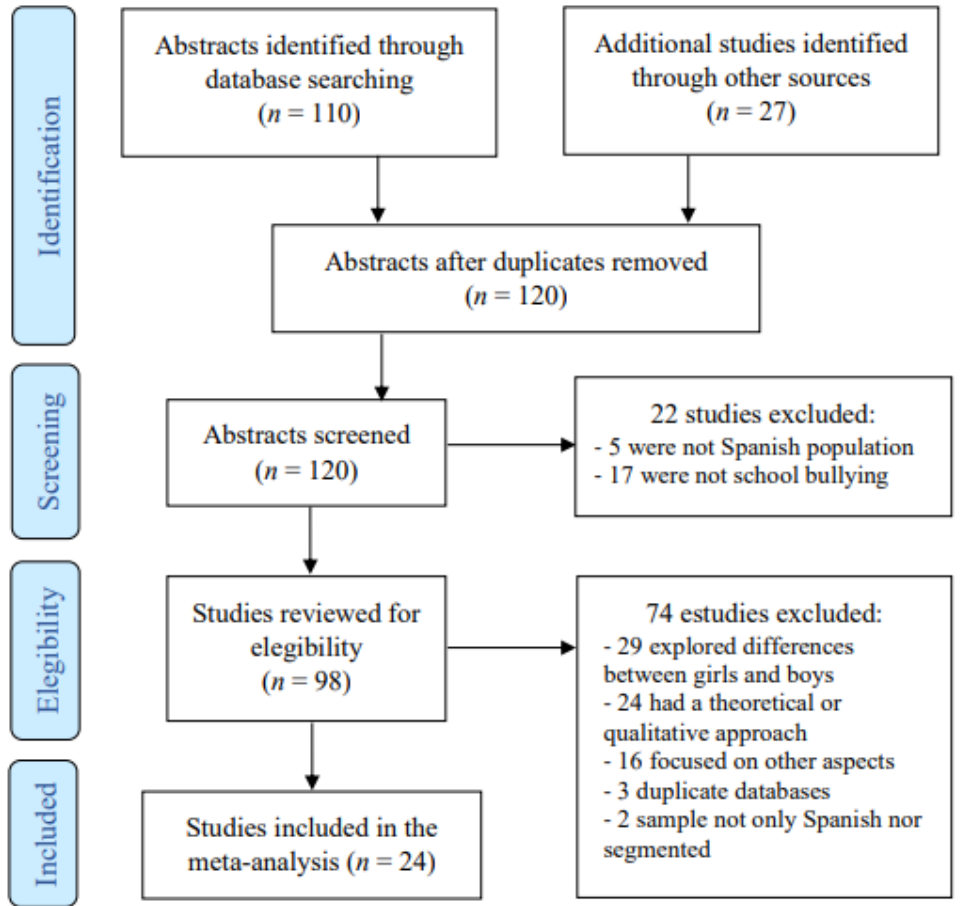
Figure 1. Flowchart of systematic search. Based on PRISMA 2009 Flow Diagram [20].